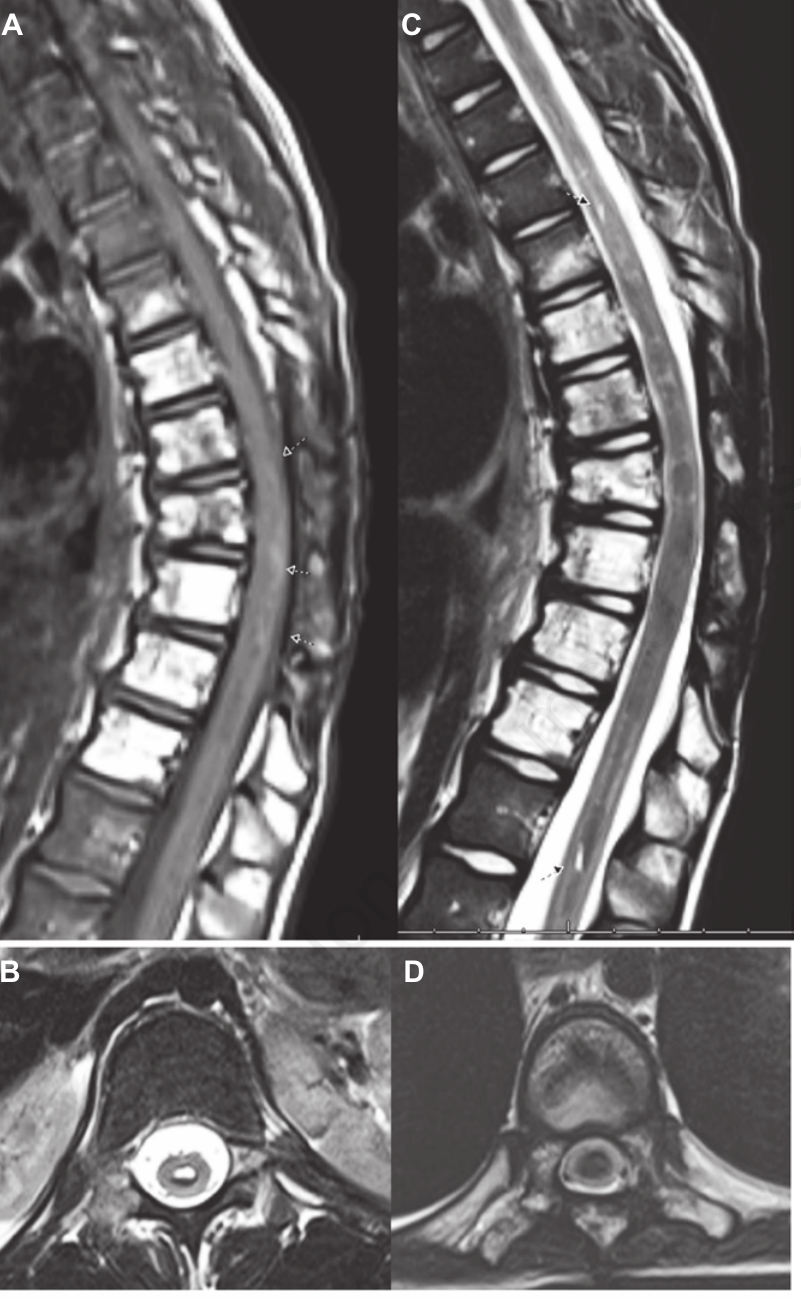
Figure 3. Sagittal and axial images from MRI scan seven months after the last adminis- tered radiotherapy dose. Sagittal T1-weighted images shows the heterogeneously T1 hyperintense areas within the thoracic cord (A; arrows) with corresponding low-signal on the T2 images. There is moderate expansion of the cord, especially evident on comparison with the prior scan. Fluid-blood level is noted at the caudal and cephalic end on the T2 sagittal image (B; arrows), also nicely seen on the T2 axial image (C). Signal dropout on the axial gradient image (D) confirms intramedullary